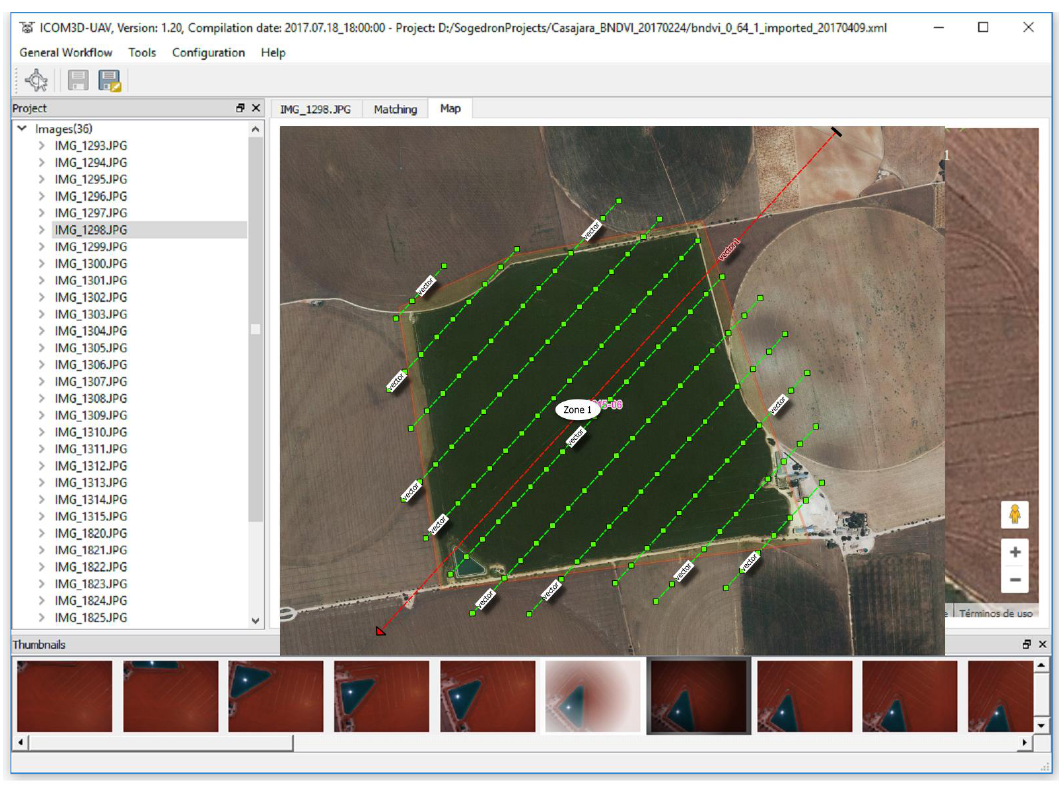
Figure 6. Flight planning over the region of interest (ROI). This planning was defined using the centroid X , Y , Z coordinates of the ROI together with the flight direction and the date/time of the flight.